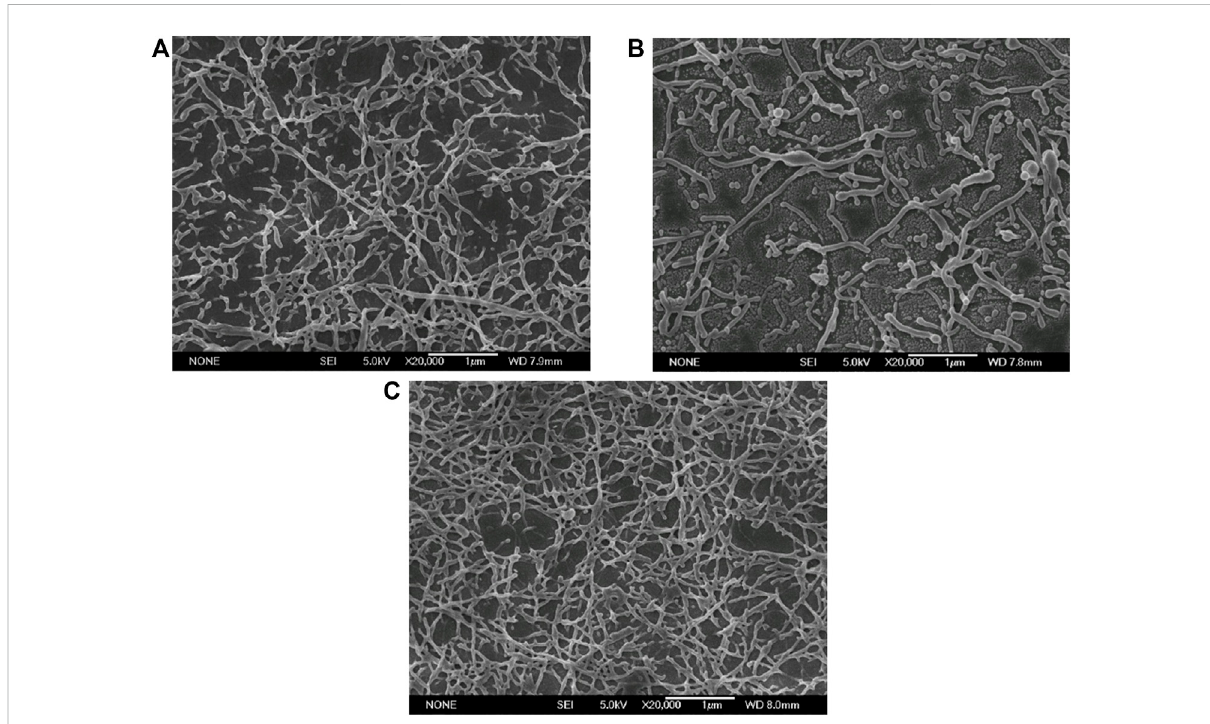
FIGURE 6 Electron micrographs of PLGA nanoparticles prepared with different PVA 1 concentrations (Scale bar: 1 μ m). (A) .1 wt%; (B) .5 wt%; (C) 1.0